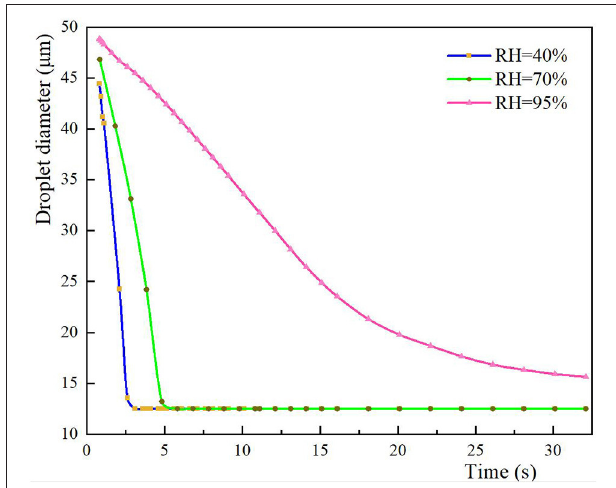
FIGURE 8 | Comparison of droplet evaporation times when the RH is 40, 70, or